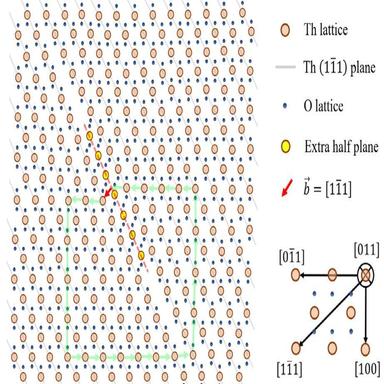
Schematic representation of 1/3111 Frank partial dislocation loop showing extra half plane and Burgers vector when seen along zone axis.